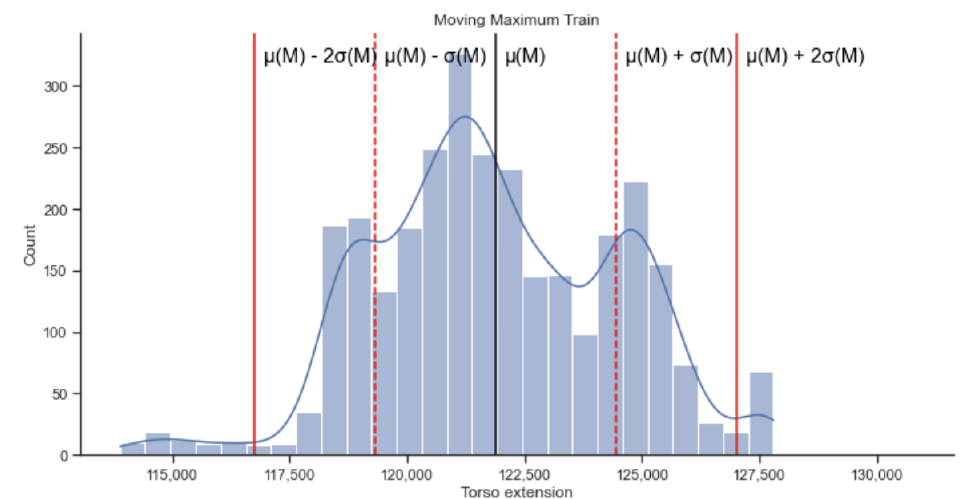
Figure 5. A histogram of moving maximum values for the training data. The black line represents the mean of the distribution, the dashed red line represent 1 std away from the mean, and the thick red line represent 2 std away from the